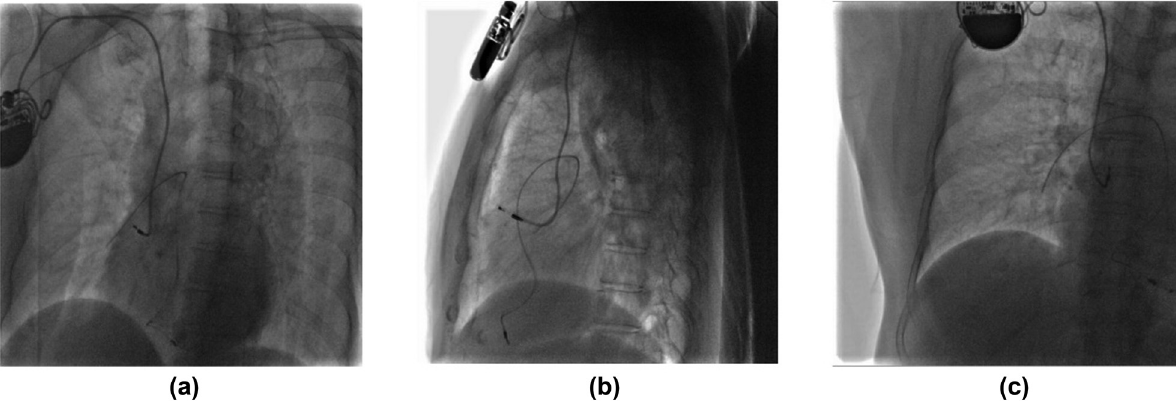
lead fracture ( Figure 2c ) . The results of chest fl uoroscopy con fi rmed that the free end of the fractured ventricular lead was in a fi xed position and did not move with